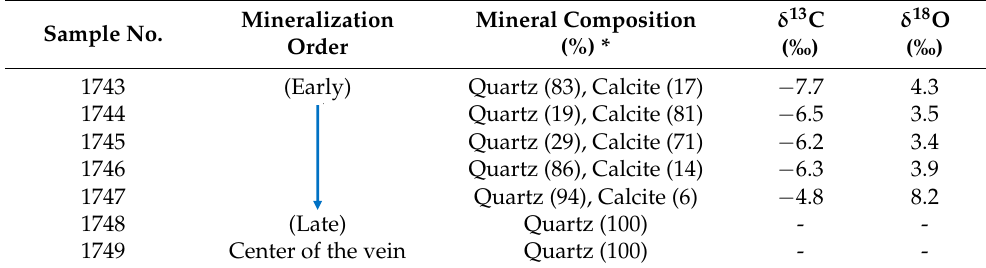
*: Approximate mineral composition was obtained from the XRD calibration